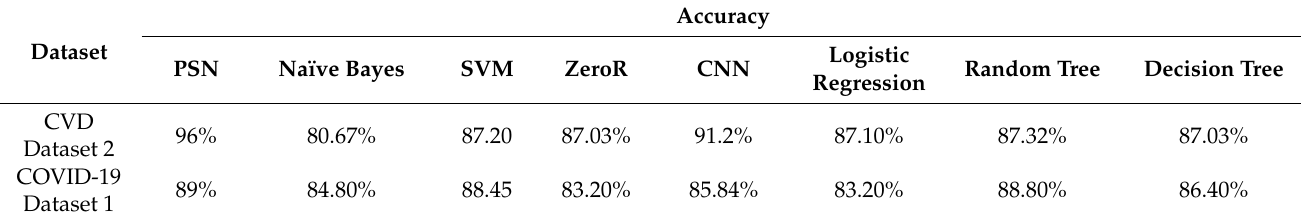
Table 5. Benchmark PSN model compared to other classification